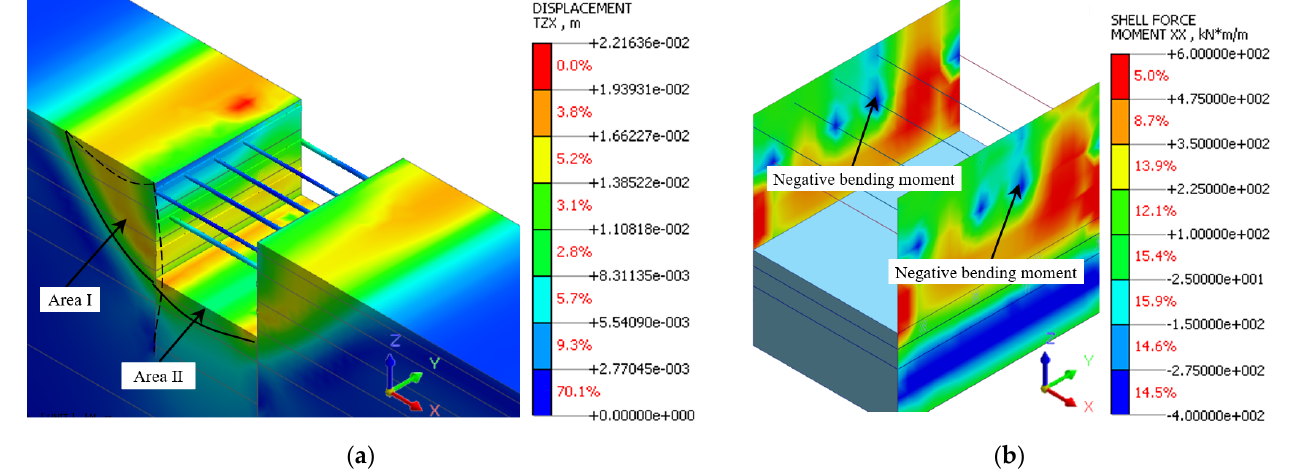
Figure 8. Diagram of the deformation diagram of the foundation pit excavation and the bending moment diagram of the support structure after the 7.20 Henan rainstorm. ( a ) Deformation of the foundation pit after the 7.20 Henan rainstorm; ( b ) bending moment of the support structure after the 7.20 Henan rainstorm.